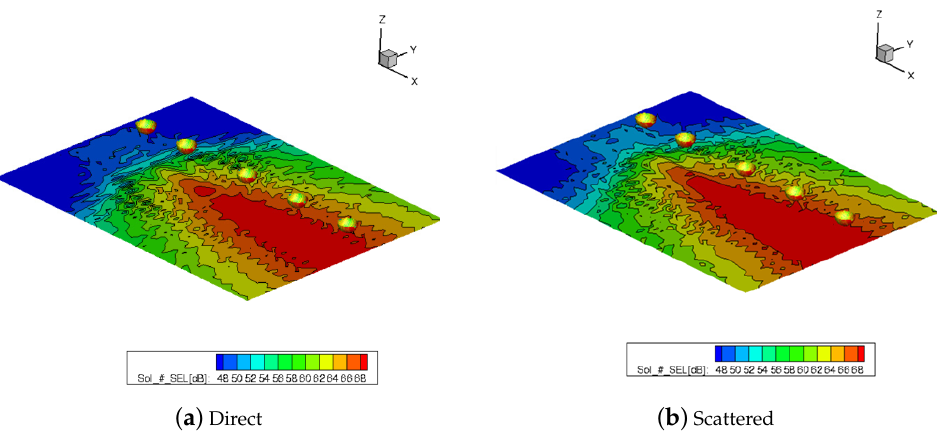
Figure 21. Comparison of Sound Exposure Level carpets. Clean case without acoustic installation effects ( a ) and with installation effects ( b ).